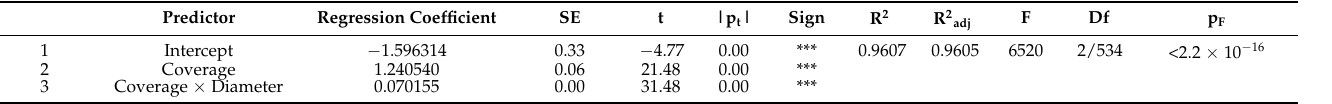
Table 6. Statistical parameters of the best model, No. 7 from Table 5, describe the relationship Volume of fine woody debris (m 3 /ha) = f(x). Coverage represents the proportion of a plot area covered by all deadwood pieces if placed next to each other given in %, and Diameter is mean diameter of fine deadwood pieces in mm.